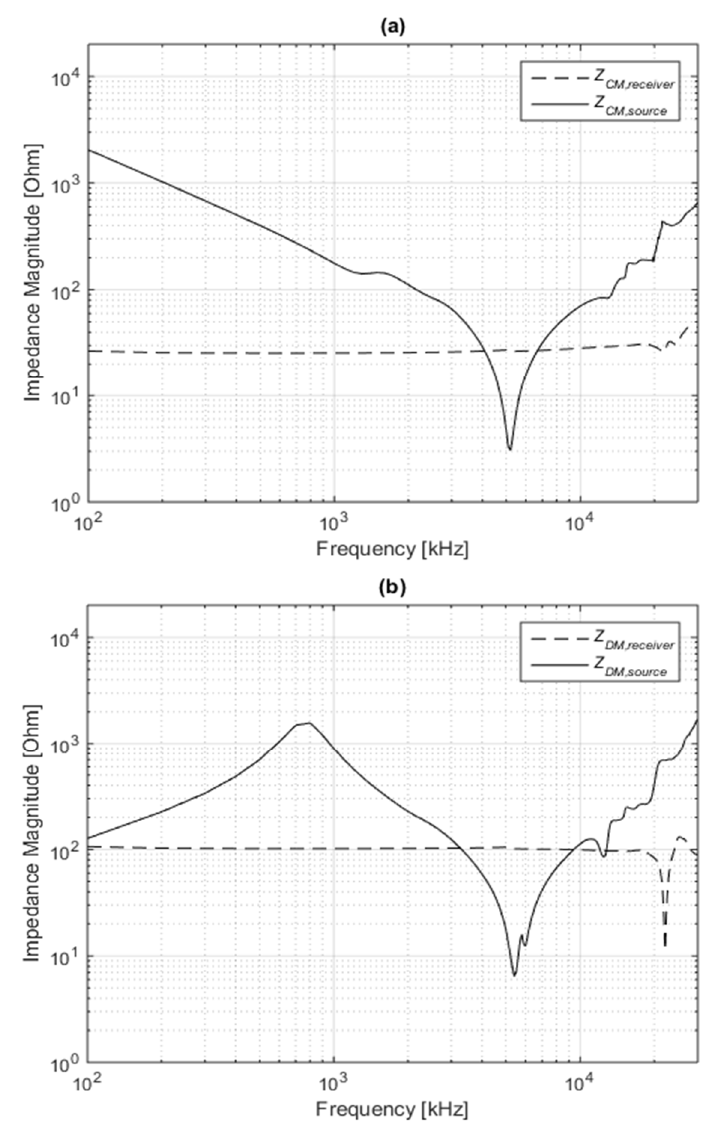
Figure 5. Frequency characteristics of the common mode (CM) noise source/receiver impedance ( a ); frequency characteristics of the differential mode (DM) noise source/receiver impedance ( b ).